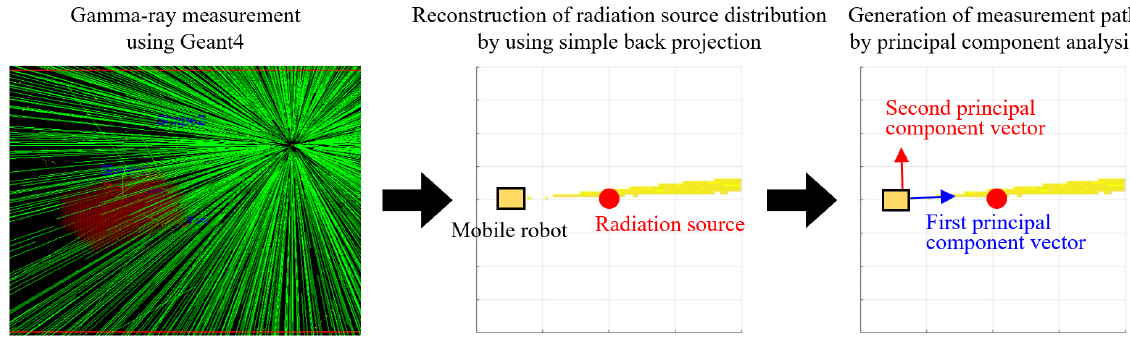
Figure 9. Process of simulation experiments: the measurement data of gamma rays were produced using Geant4. Then, the radiation source distribution was reconstructed via simple back-projection. Finally, the next measurement point was determined using the PCA based on previous